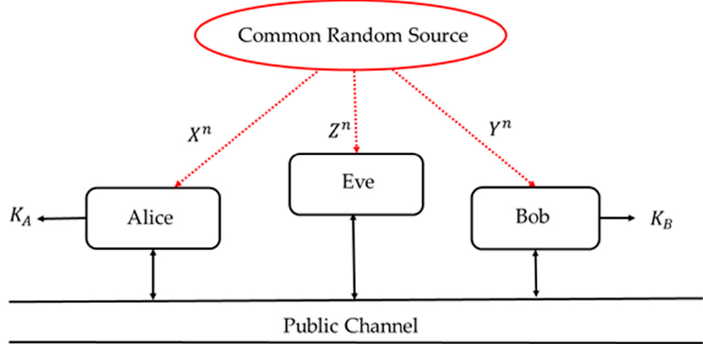
Figure 1. Source model of the secret-key agreement via public discussion from common random- ness.